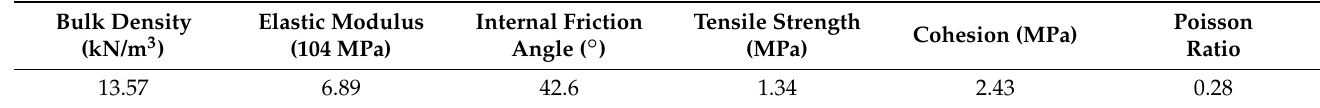
Table 1. Macro-mechanical characteristics of the moulded coal specimen.